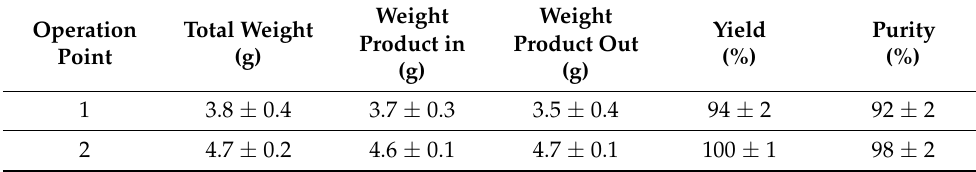
Figure 12. Normalized output signal of the slug. Recorded with a conductivity detector at a volume flow rate of ( a ) 0.2 mL/min and ( b ) 1 mL/min. Table 5. Fraction properties, purity, and